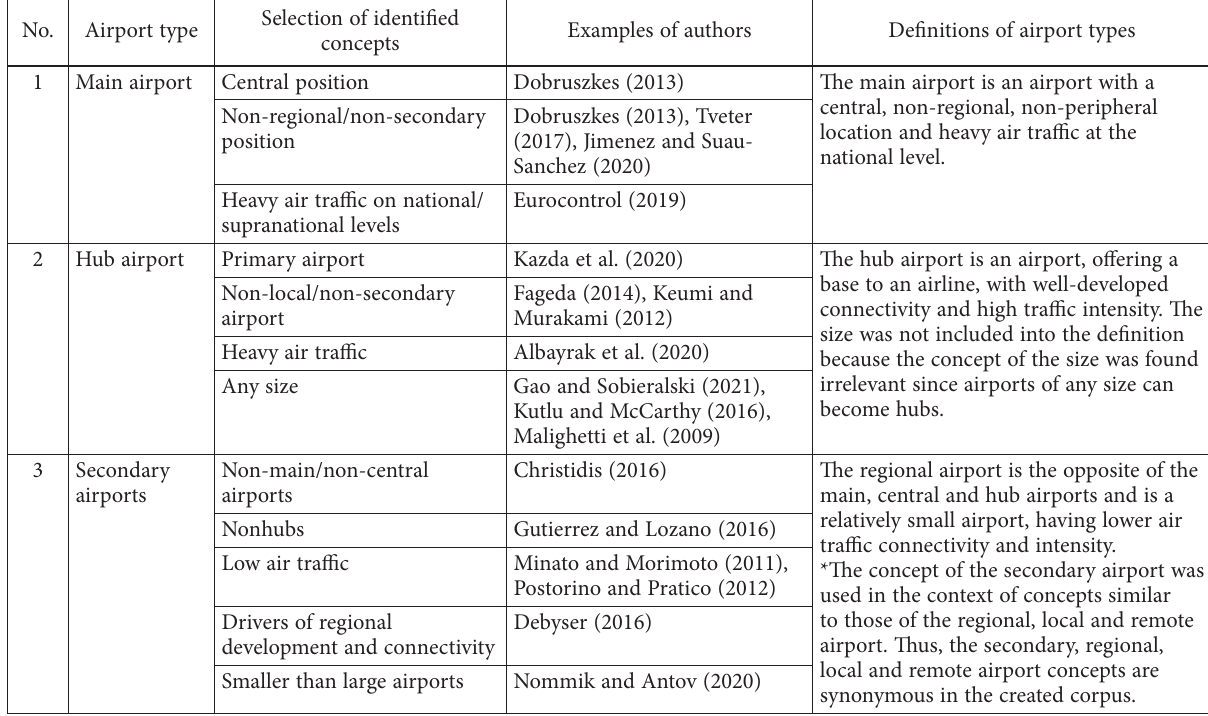
Table 4. Summary of the selected concepts for airport definitions (created by the authors) No.